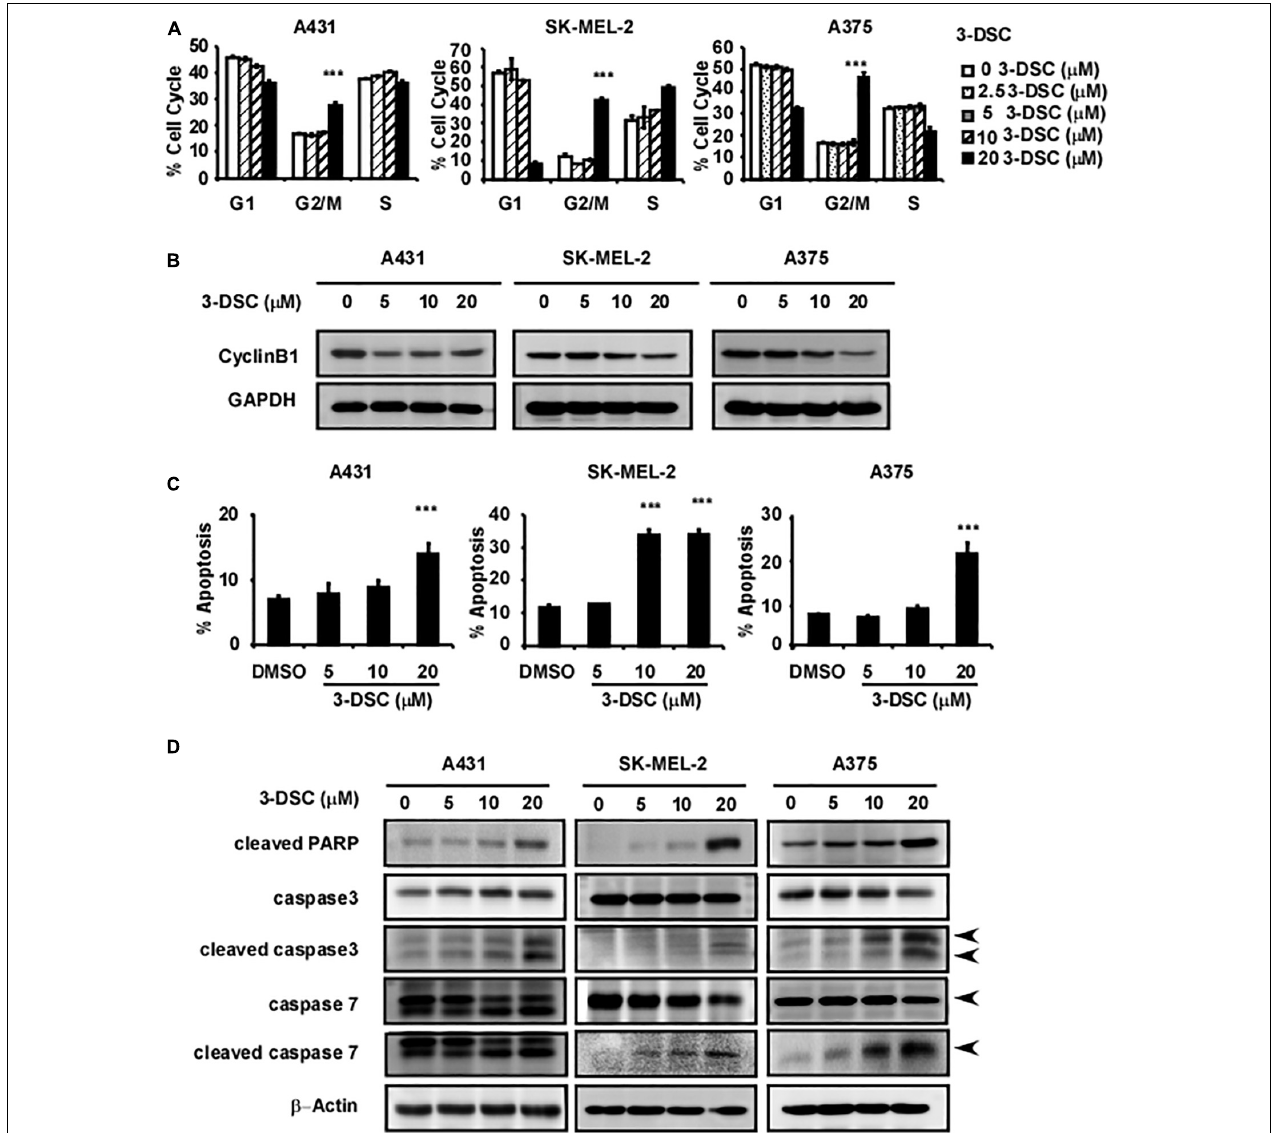
FIGURE 4 | 3-DSC induces arrest at G2/M phase and cell apoptosis in skin cancer cells. (A) Effect of 3-DSC to skin cancer cells’ cell cycle. (B) G2/M phase marker cyclin B1 protein expression level in skin cancer cell lines after treatment with 3-DSC at various concentrations. (C) 3-DSC induces apoptosis in skin cancer cell lines. Skin cancer cells were incubated with various concentrations of 3-DSC for 48 h and analyzed for apoptosis markers indicating pre/late apoptosis by flow cytometry. Data are shown as mean ± SD values. (D) Cell apoptosis marker cleaved PARP/cleaved caspase 3/cleaved caspase 7/PARP/caspase 3/caspase 7 expression after 3-DSC treatment. 3-DSC treatment increased cleaved PARP/cleaved caspase 3/cleaved caspase 7 protein expression in a dose-dependent manner. *** p <